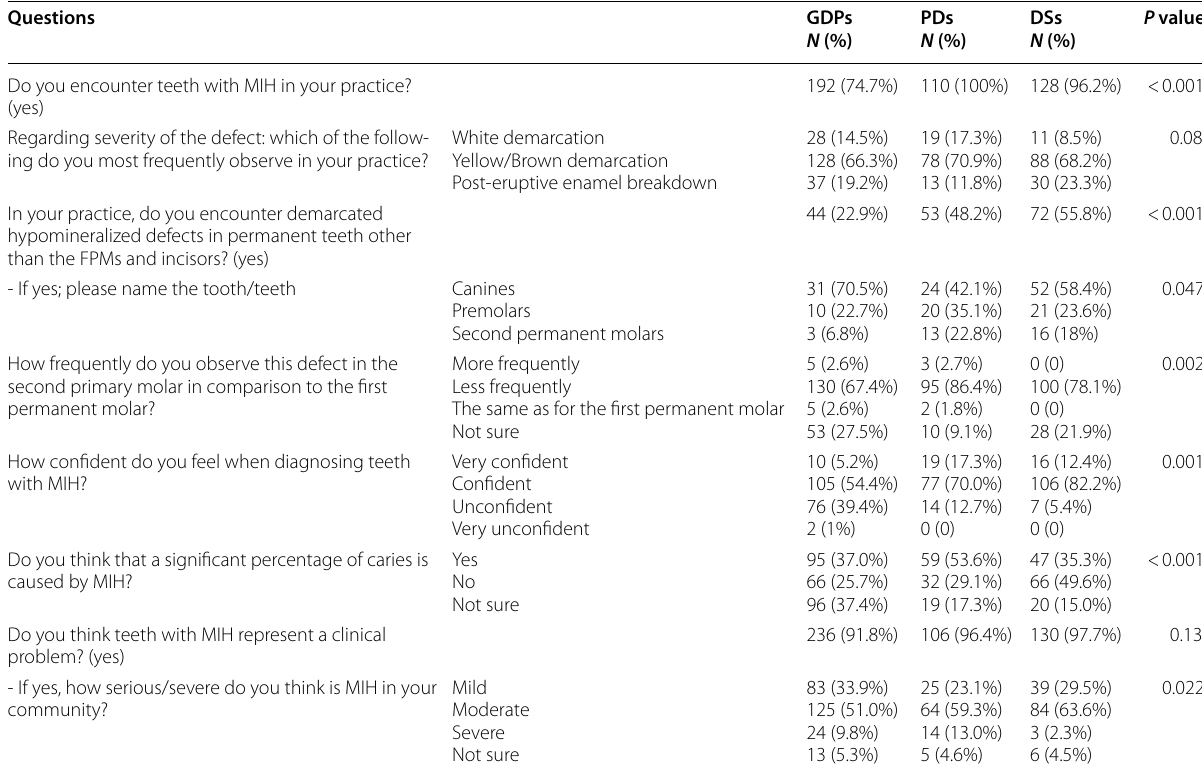
Table 2 Perceptions and clinical experience concerning the clinical appearance, diagnosis, and prevalence of